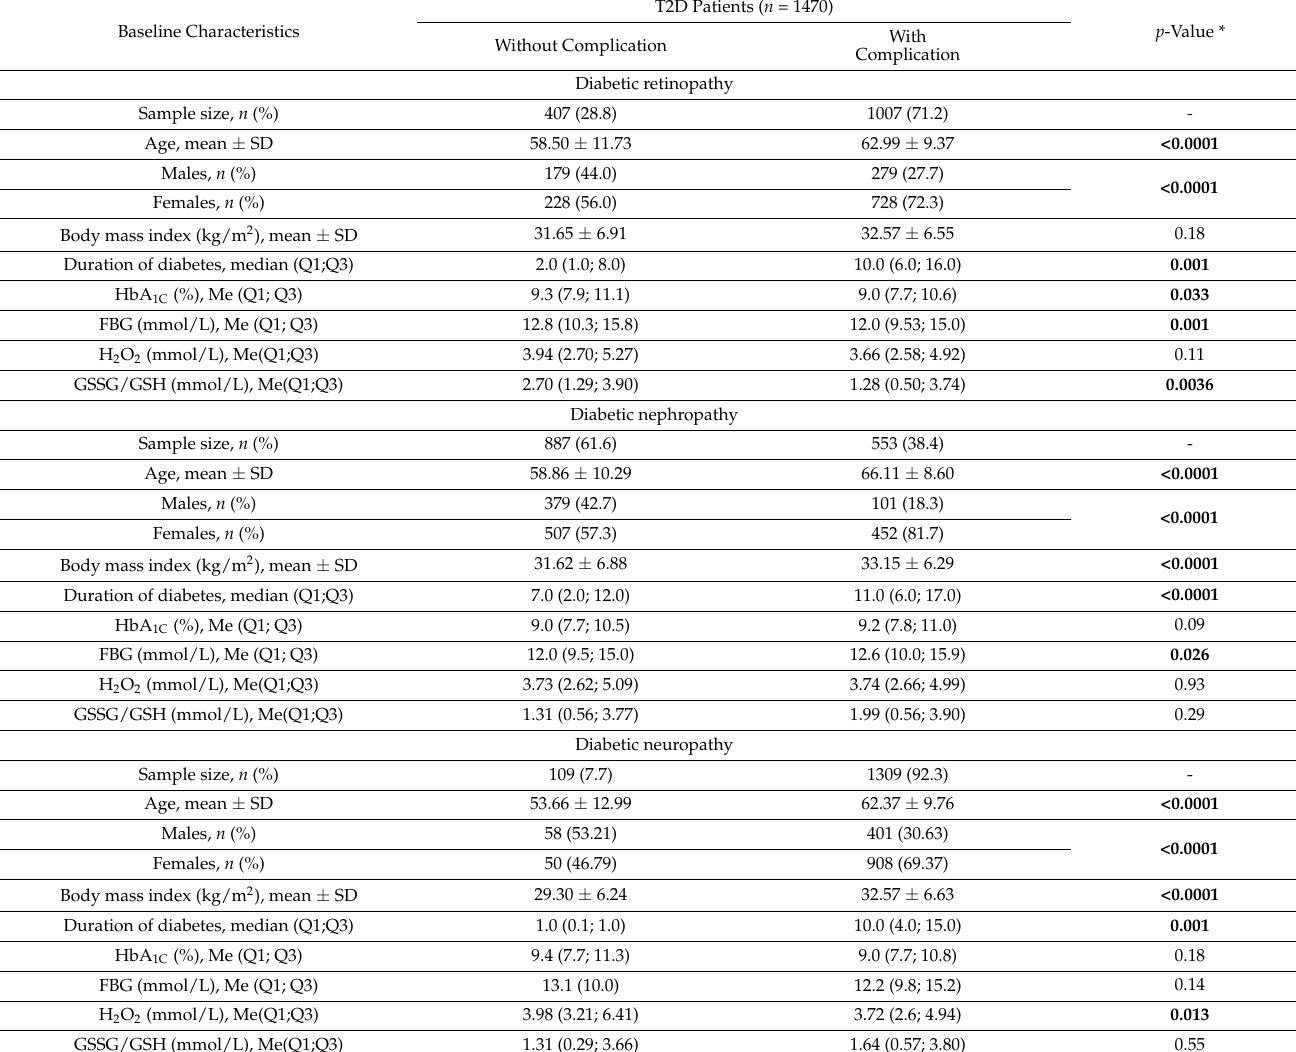
Table 1. Demographic, clinical, and biochemical characteristics of the study